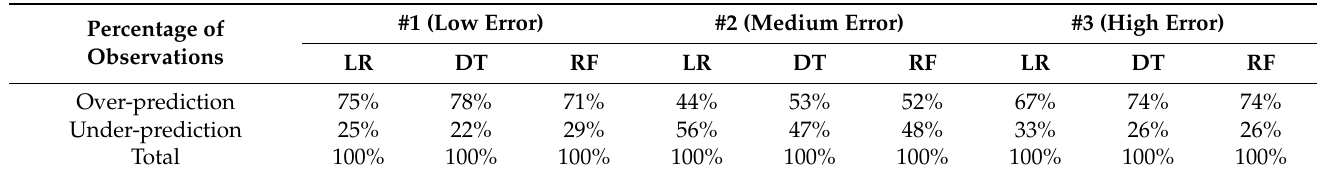
Table 8. Over-prediction and under-prediction per cluster and